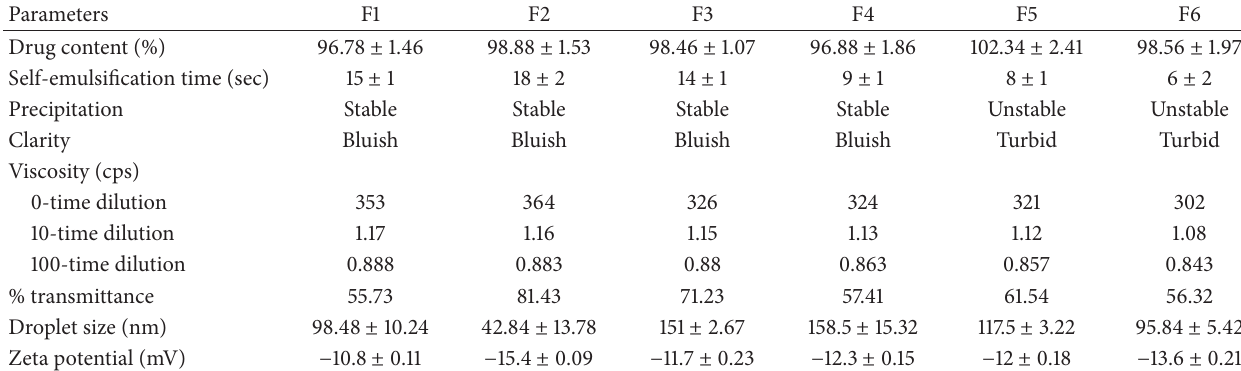
Table 4: Characterization of SNEDDS